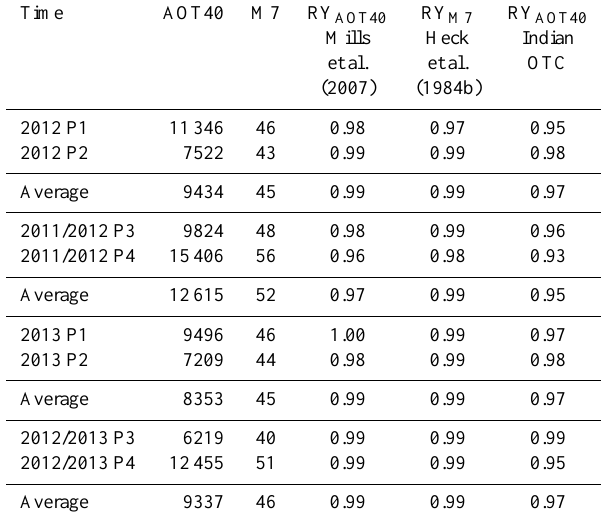
Table 8. Ozone exposure according to different exposure indices and relative yields for rabi and kharif